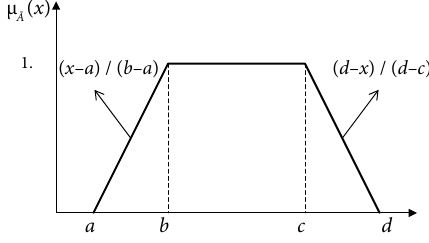
Fig. 1. membership function of STFn Ã